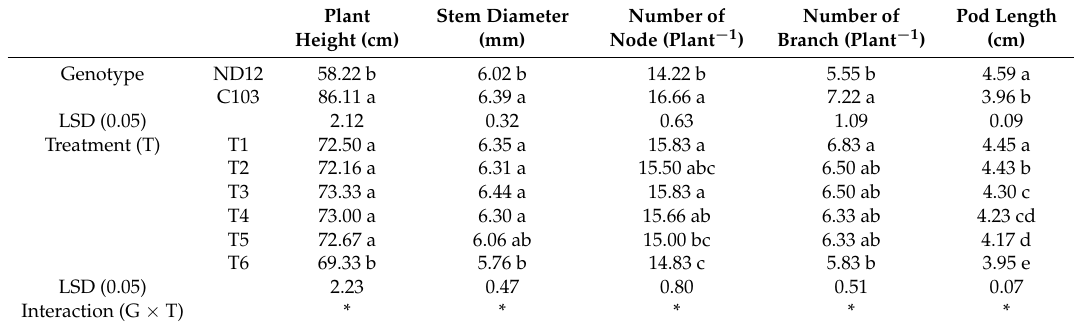
Table 1. Soybean morphological characters under different split-root water imbalance treatments.